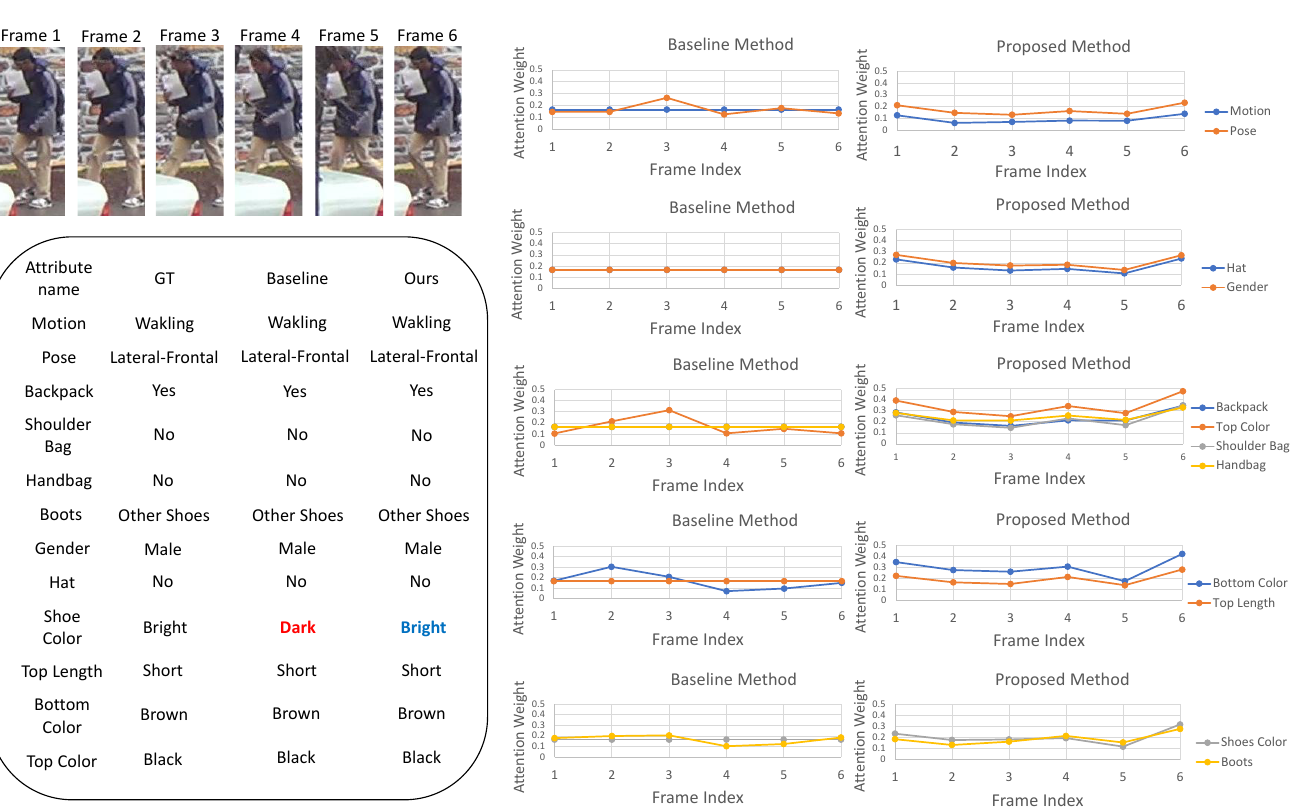
Figure 6. Qualitative results for the DukeMTMC-VideoReID dataset. It presents the attention weights of the group attributes and PAR results. For the groups related to the lower body, the proposed method has low attention weights in the occluded frames. However, the attention weights of the baseline method (Chen et al. [13]) are almost the same in all the frames.